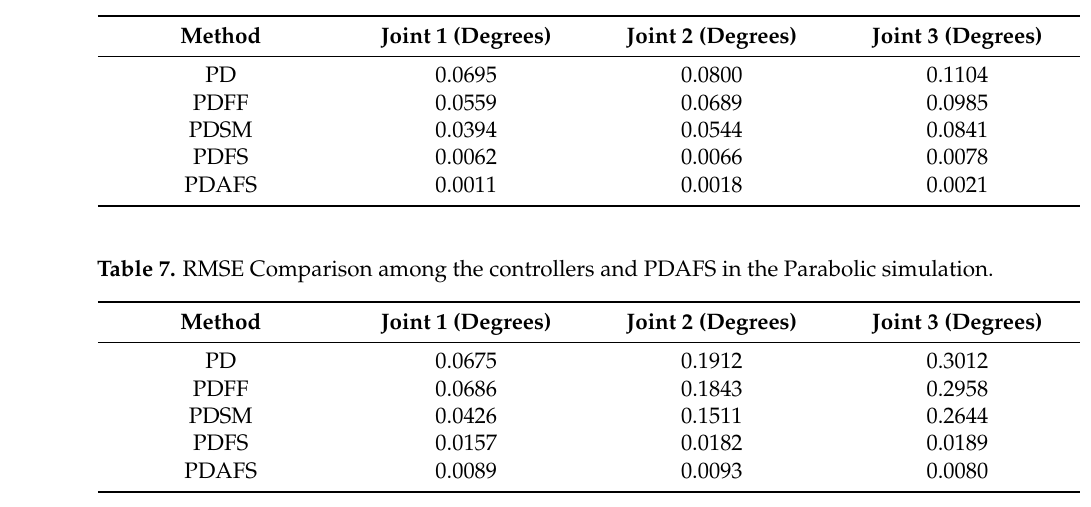
Figure 7. Tracking error comparison among the controllers and PDAFS in the helix and parabolic simulation: ( a ) error of joint 1; ( b ) error of joint 2; ( c ) error of joint 3 in the helix case; ( d ) error of joint 1; ( e ) error of joint 2; ( f ) error of joint 3 in the parabolic case. Table 6. RMSE Comparison among the controllers and PDAFS in the Helix simulation.